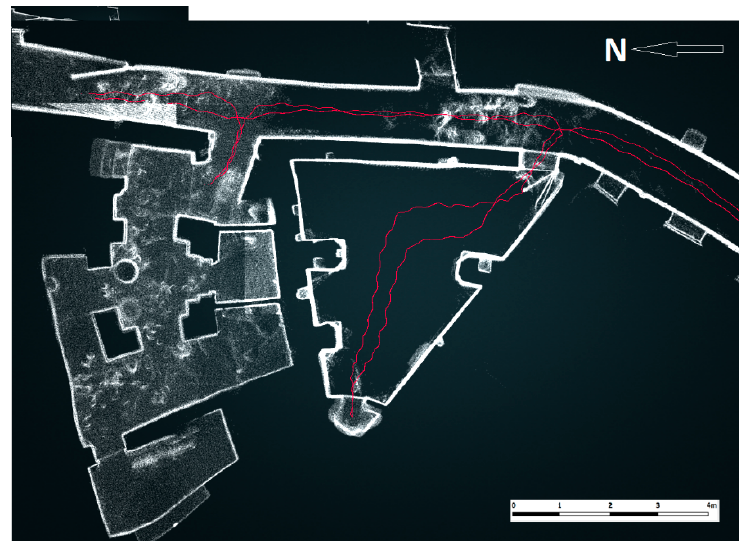
Figure 20. Graphical output from the ZEB-REVO PLS: The ground plan of structures inside the mellah (in red colour the trajectory during measuring). This output can be produced in dozens of minutes.